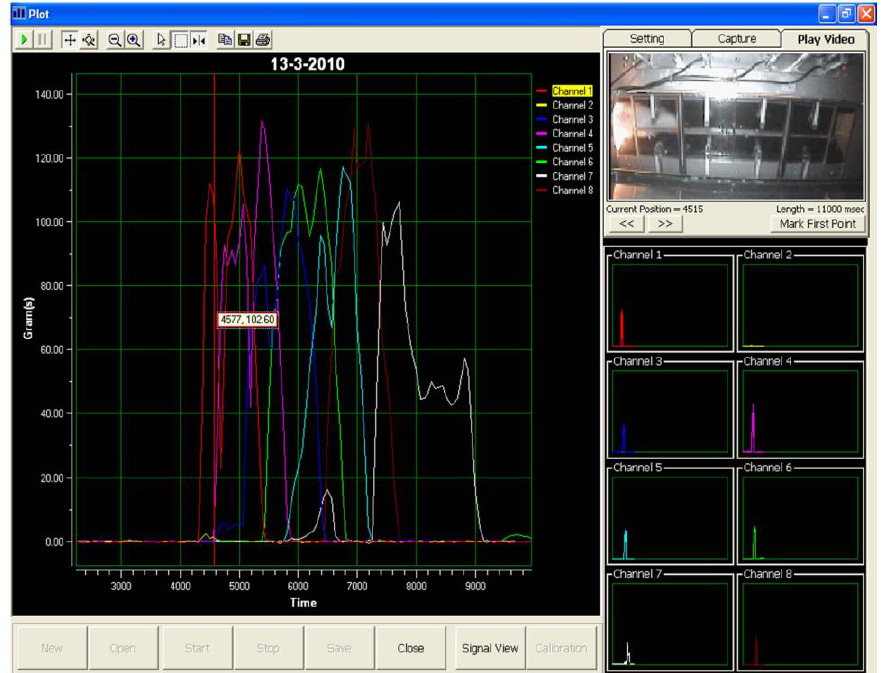
Figure 6. Vertical peaks show front paw and hind paw.